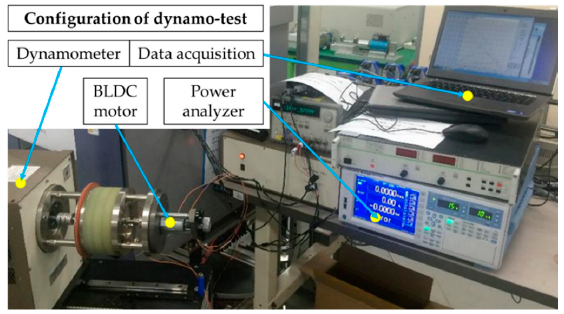
Figure 10. Prototype of optimal design: ( a ) Assembly; ( b ) Stator; ( c ) Rotor.